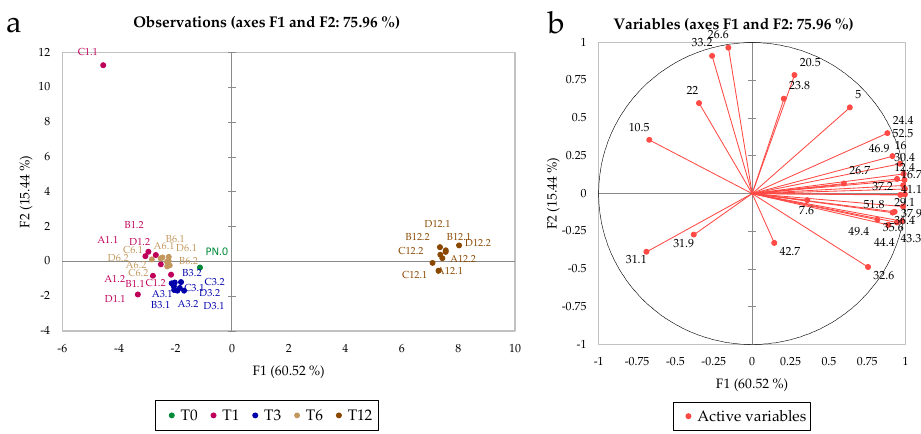
Figure 2. Observations and plots of variables based on HPLC ‐ DAD data. Loadings are labelled by peak retention times. Numbers refer to months (of storage) and sample replicates. Letters refer to the specific treatment (see Figure 1 for details on the treatment). Please, see Table S1 (Supporting Information) for details on the peak assignment. ( a ) Scores plot, ( b ) Loadings plot.